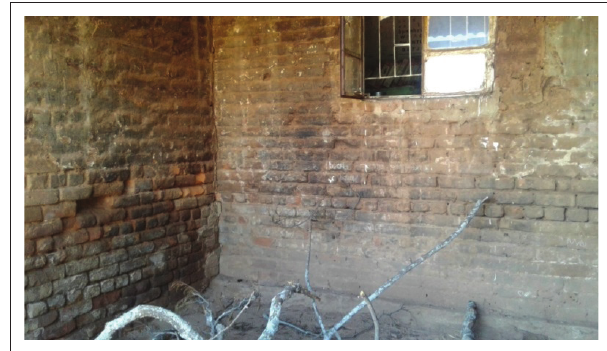
Source : Photograph taken by, Participant 3 FIGURE 1: Classroom with broken window panes, exposing learners to bad weather and thieves.